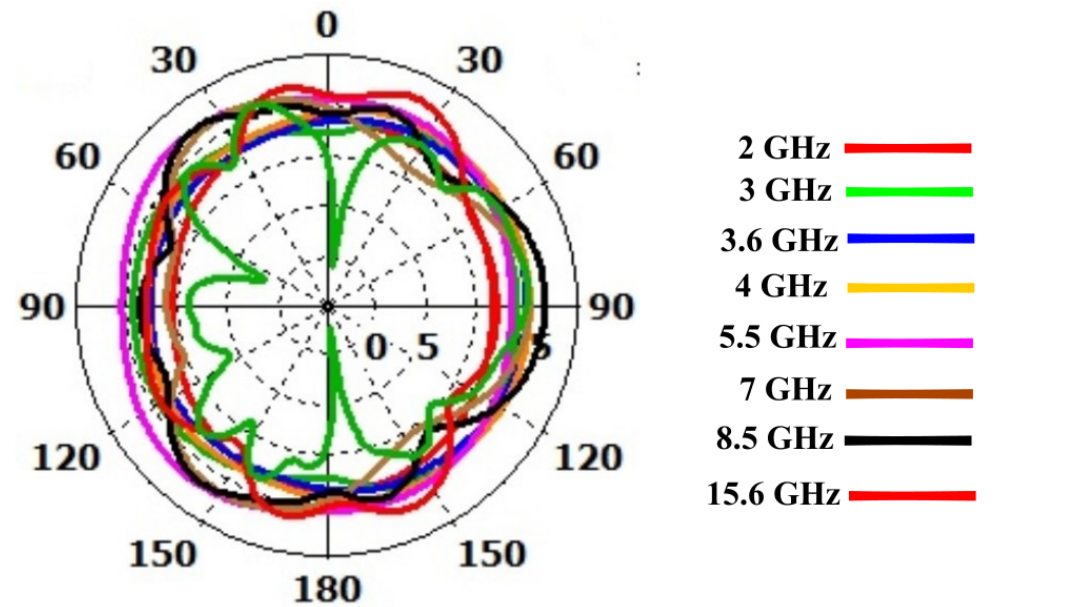
Figure 8. Power Pattern (YZ-plane) with the λ /20 Dipole.